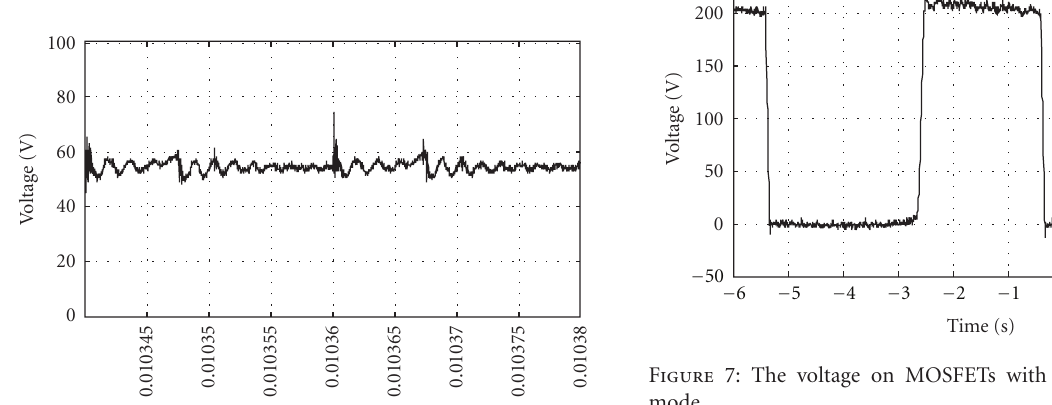
Figure 4: The voltage on MOSFETs with sliding mode.